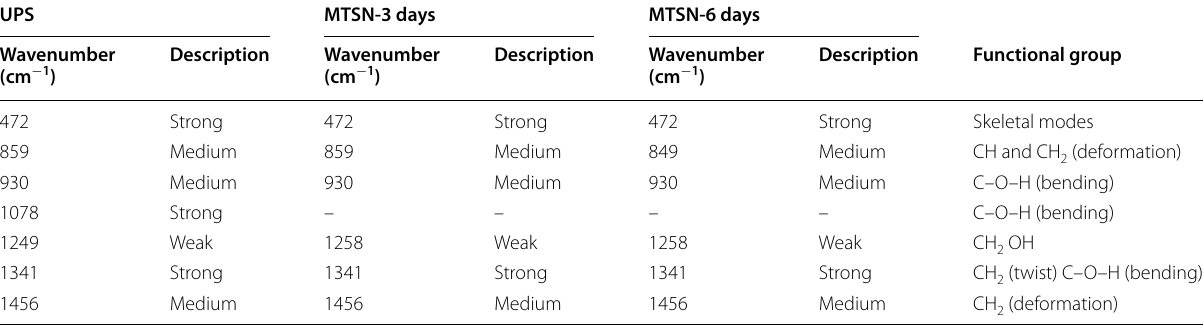
Table 8 Untreated potato starch (UPS) wavenumbers portrayed in Raman analysis with corresponding functional groups compared to mechanically treated starch nanoparticles (MTSN-3 days and MTSN-6 days) absorption spectrum